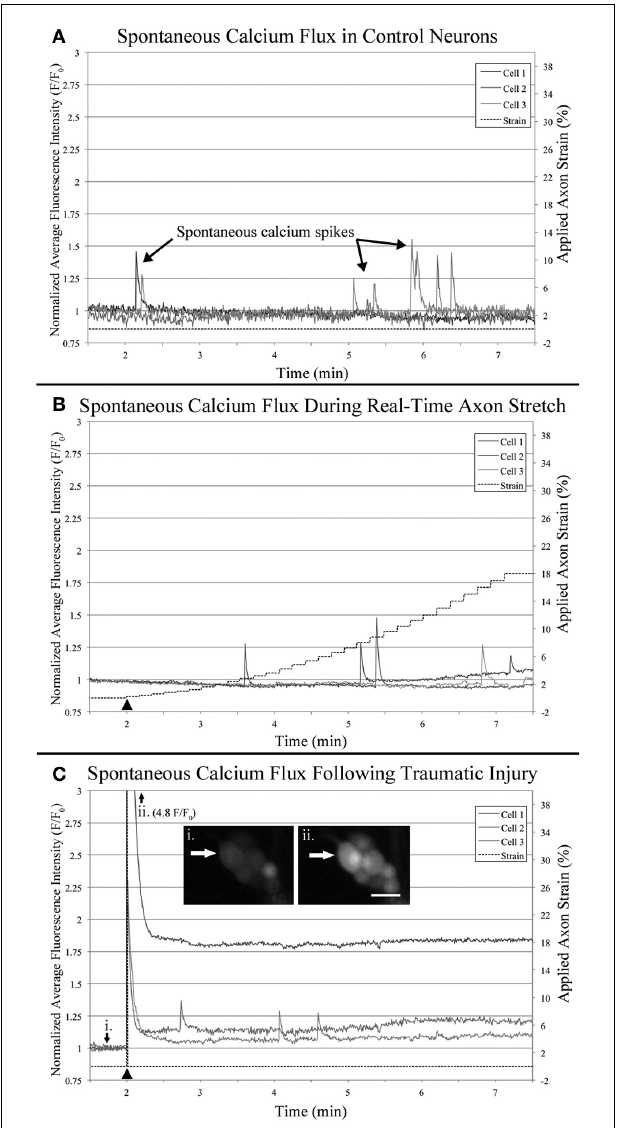
FIGURE 7 | Functional calcium imaging. Cells were loaded with Fluo-4AM and imaged over 10min time-lapse sequences which were quantified and plotted. All cells which spiked during the first minute of recording were excluded from analysis to reduce background noise. Examples plots represent: (A) Control neurons within sham bioreactors, (B) Neurons undergoing real-time stretch, and (C) Stretch-injured cells subjected to 40% strain over 30 s − 1 , (i) before injury, (ii) immediately after injury. Bar = 25 μ m.